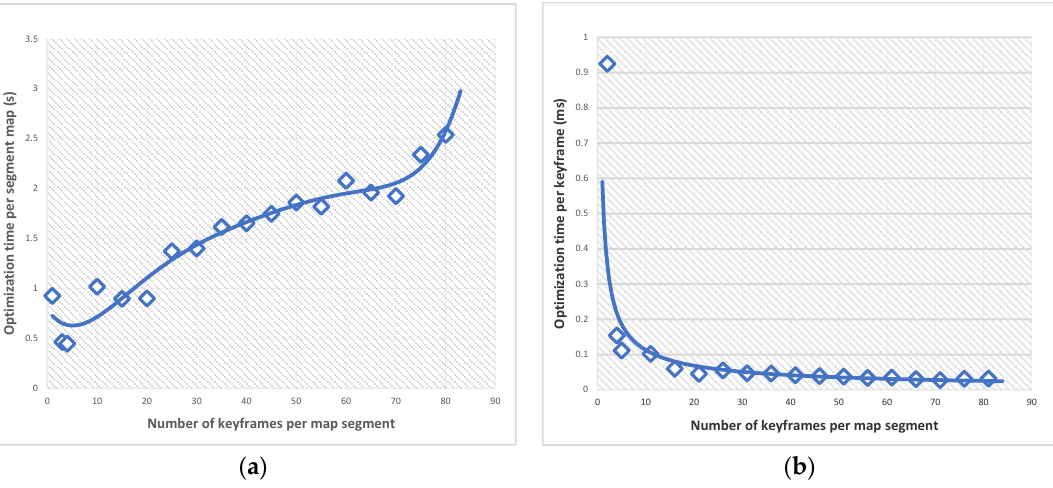
Figure 21. ( a ) Correlation between the overall optimization time of the map segment and the number of keyframes per map segment and ( b ) correlation between the average optimization time of each keyframe and the number of keyframes per map segment. Table 10. Average computation time of each operation for every map segment (40 keyframes) in LiDAR data optimization thread.